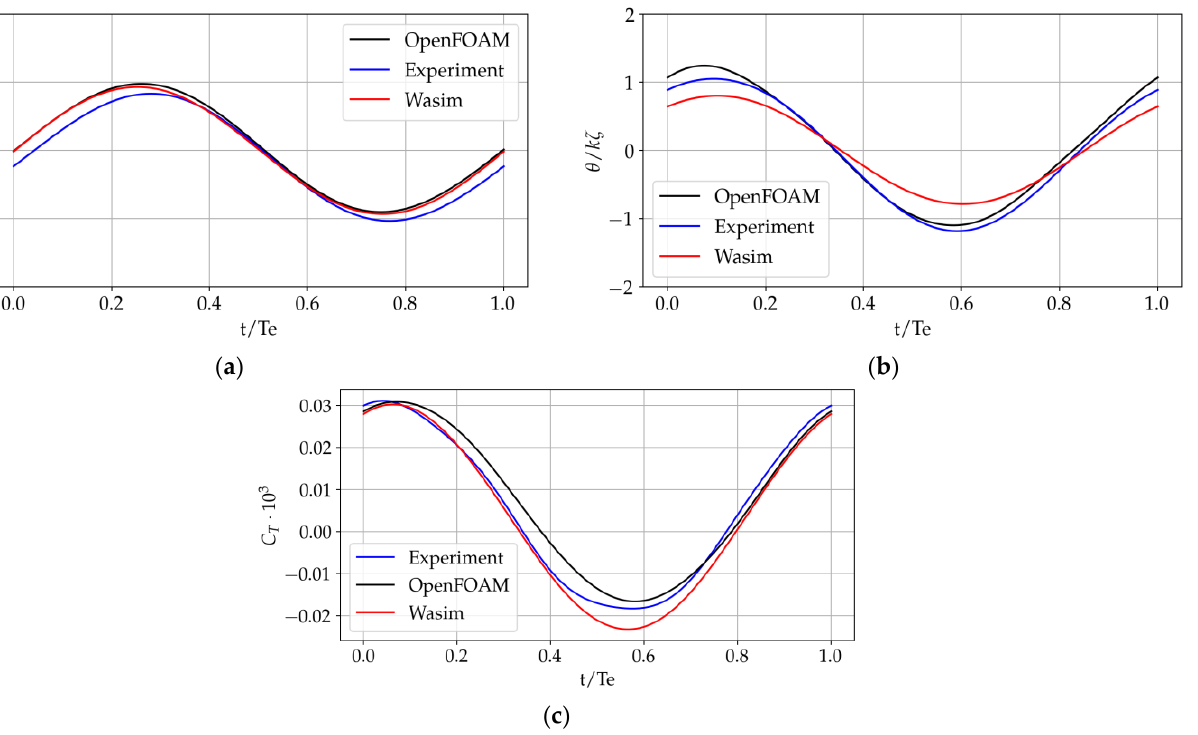
Figure 26. Time histories for case 5 of the KRISO containership: nondimensional ( a ) heave, ( b ) pitch, ( c ) total resistance.